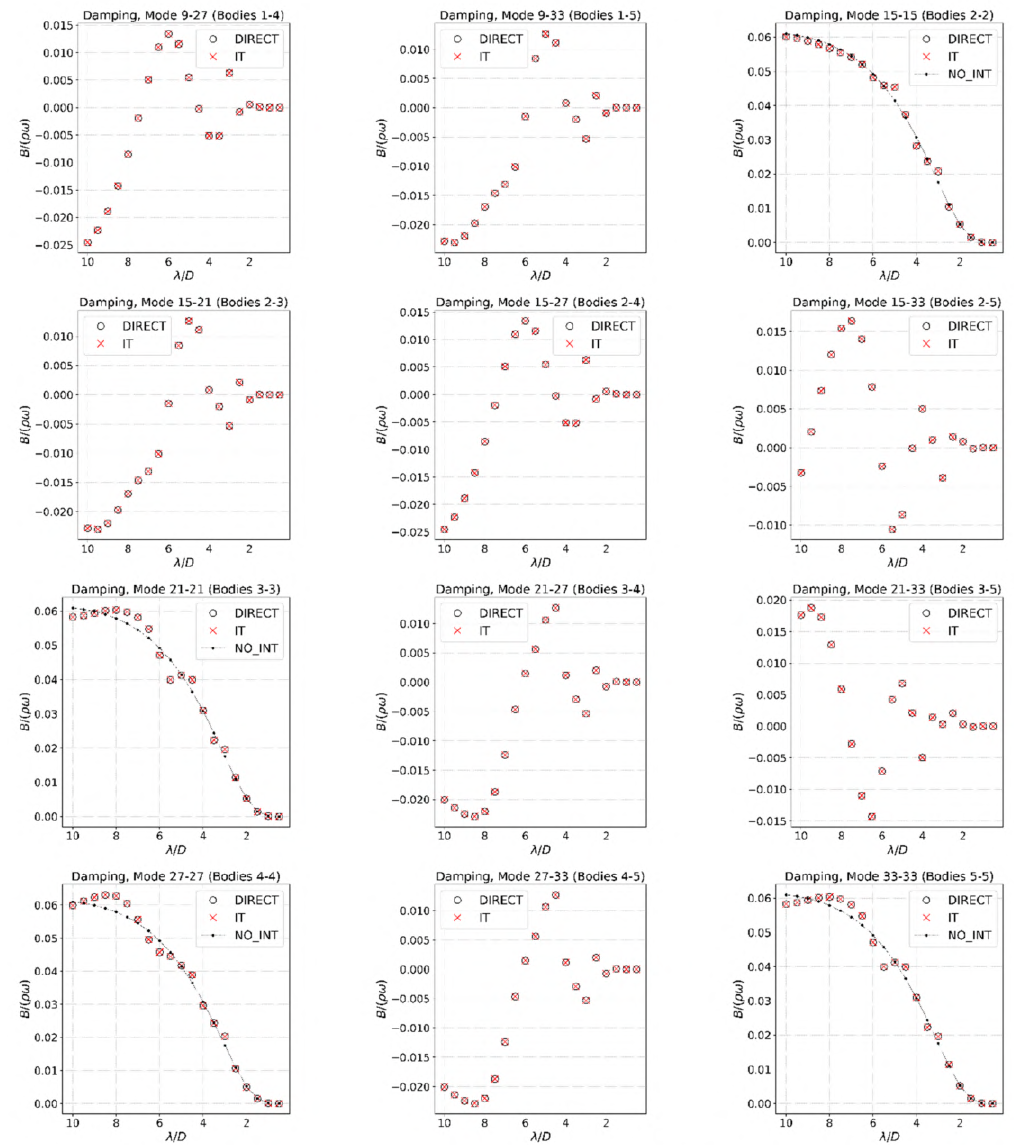
Figure 7. Wave radiation damping coefficients for heave motion. “DIRECT”, “IT”, and “NO_INT” denote the solution using WAMIT with the direct method, the solution using the interaction theory, and the solution for a single isolated body using the direct method and body W 1 , respectively. A denotes the added mass, ρ stands for the fluid density, and ω is the angular